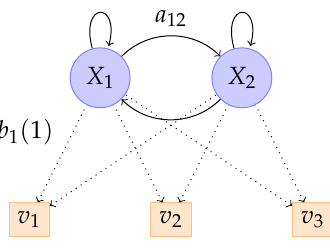
Figure 1. A hidden Markov model (HMM) with two states and three discrete observations, where a ij is the probability of transition from state X i to state X j and b j ( k ) is the emission probability for symbol v k in state X j